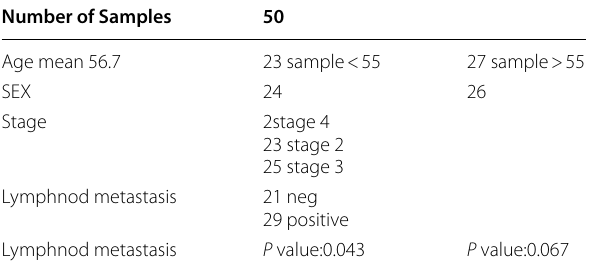
Table 1 Clinicopathological features of patients with lung cancer